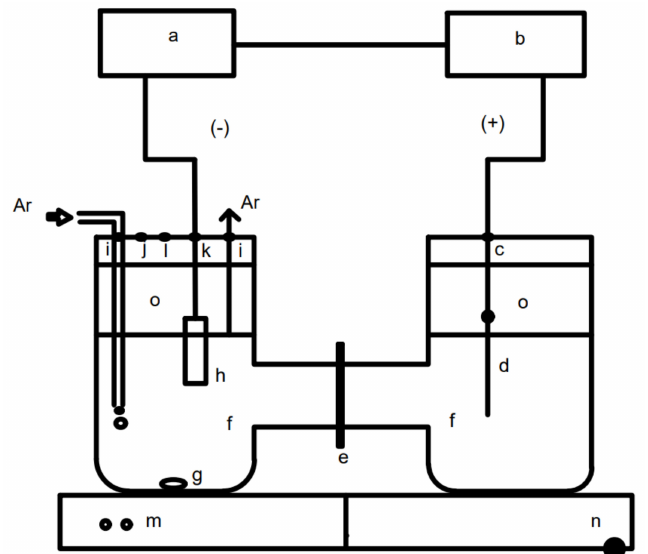
Figure 1. Experimental apparatus for dechlorination: ( a ) digital coulometer, ( b ) DC power supplier, ( c ) anode hole, ( d ) anode, ( e ) Nafion membrane-N117, ( f ) electrolytic solution, ( g ) teflon-coated magnet bar, ( h ) cathode, ( i ) gas hole, ( j ) sampling hole, ( k ) cathode hole, ( l ) reference electrode hole, ( m ) magnetic stirrer, ( n ) packing block, and ( o ) glass